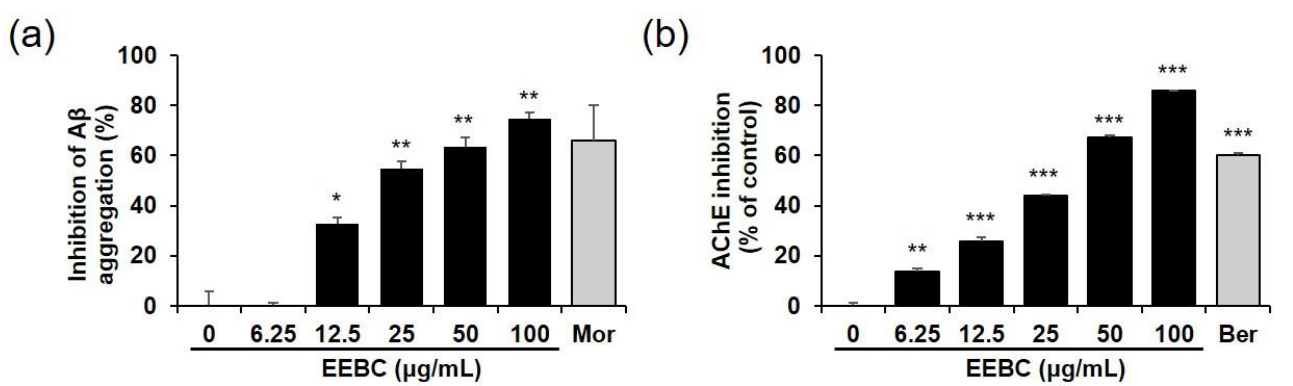
Figure 4. Effects on EEBC on amyloid-β (Aβ) aggregation and acetylcholinesterase (AChE) activity in vitro. ( a ) Various concentrations of EEBC (0, 6.25, 12.5, 25, 50, or 100 μg/mL) were mixed with Aβ (1–42), followed by the addition of 10 µL of thioflavin T dye. Fluorescence of thioflavin T was measured at intervals of 20 min for 2 h, with an excitation wavelength (λ ex ) of 440 nm and an emission wavelength (λ em ) of 485 nm on a SpectraMax i3 Multi-Mode Detection Platform. Morin (100 μM) was used as the positive control; ( b ) Various concentrations of EEBC (0, 6.25, 12.5, 25, 50, or 100 μg/mL) were mixed with the substrates acetylthiocholine iodide and DTNB, and incubated for 10 min at room temperature. AChE solution was then added to the initial mixture and incubated again for 1 h at room temperature. Absorbance was measured at 412 nm using an Epoch microplate spectrophotometer. Berberine (0.5 μM) was used as a positive control. Each value is presented as the mean ± SEM. * p < 0.05, ** p < 0.01, or *** p < 0.001 vs. control. EEBC: ethanol extract of B. coccinea branches .